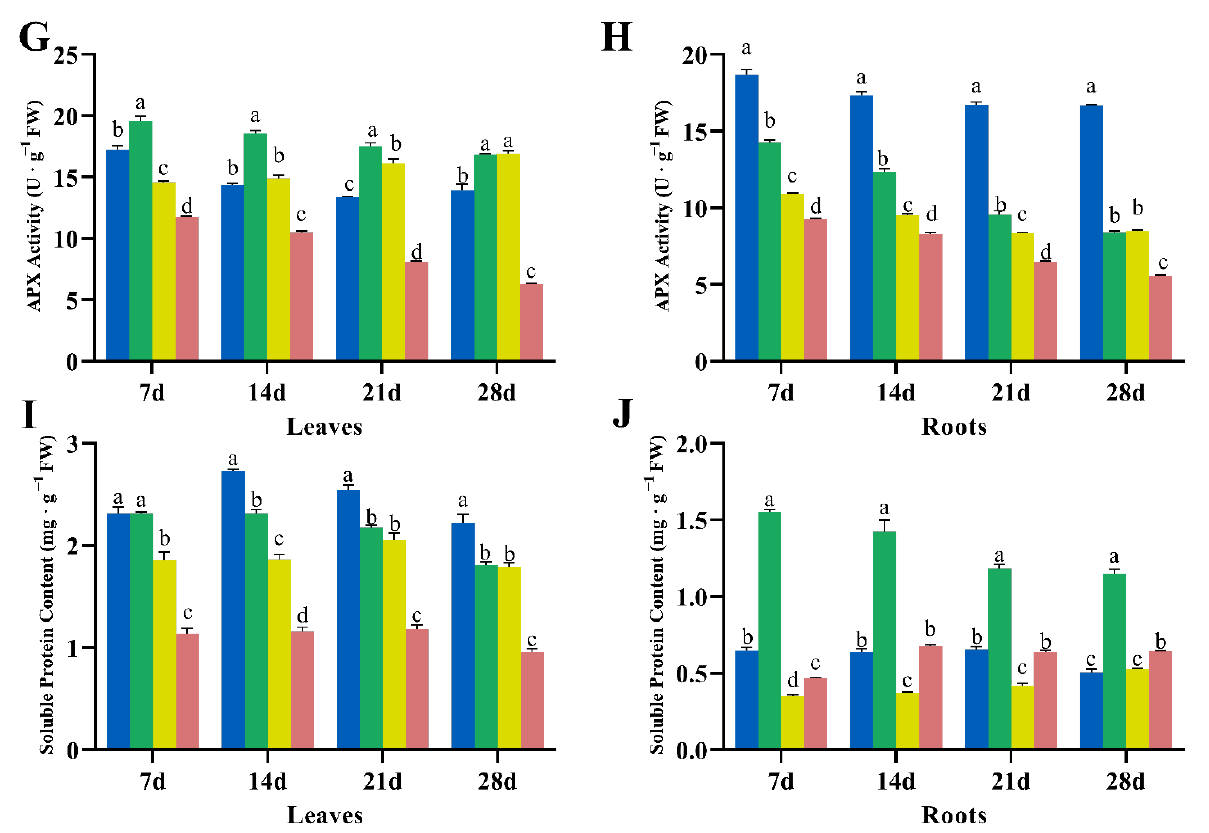
Figure 2. Effects of Cd stress on POD ( A , B ), SOD ( C , D ), CAT ( E , F ), APX ( G , H ) activity, and soluble protein content ( I , J ) in leaves and roots of M and R genotypes. The significant differences between the M and R genotypes were based on one-way ANOVA. The different letters indicate that the difference is significant at a 0.05 level. Data were shown by “means ± SE”. CK and Cd represent treatments of 0 and 1000 μM Cd, respectively.